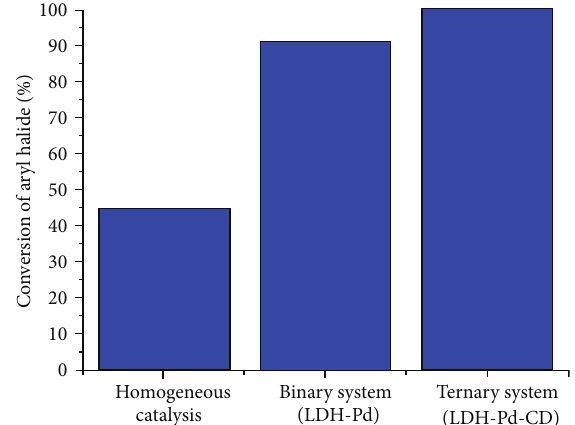
Figure 5: Differences among homogeneous catalysis, binary system (LDH-Pd) and ternary system (LDH-Pd-CD) in the reaction of iodobenzene and phenylboronic